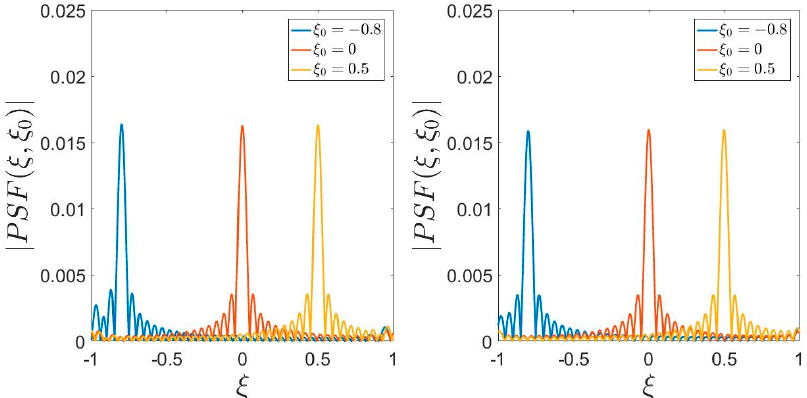
Figure 2. The point spread functions (PSFs) of the operators ˆ L θ (left panel) and L u (right panel) of a linear source with a x = 10 λ , for ξ 0 = − 0.8, 0, 0.5.